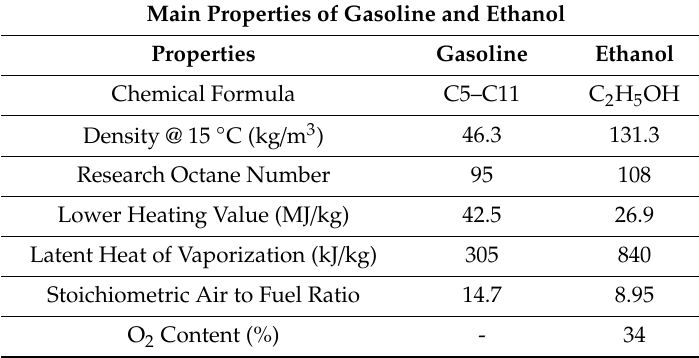
Table 2. Test fuel